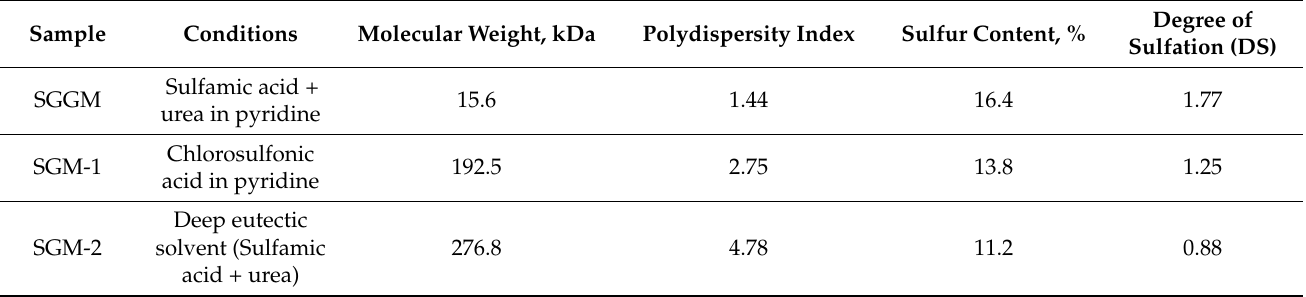
Table 2. Structural parameters of the GGM and GM